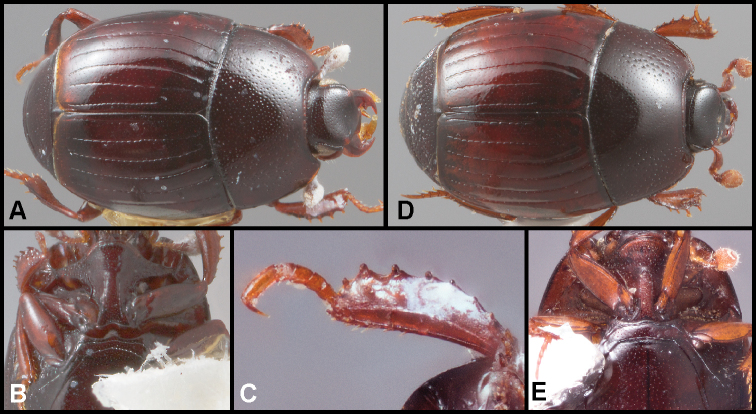
A–CPhelisterbryanti sp. nov. A Dorsal habitus B Prosternum and mesoventrite of male C Bent protarsal claws D–EPhelisterparecis sp. nov. D Dorsal habitus E Ventral view showing prosternal and meso- and metaventral striae.